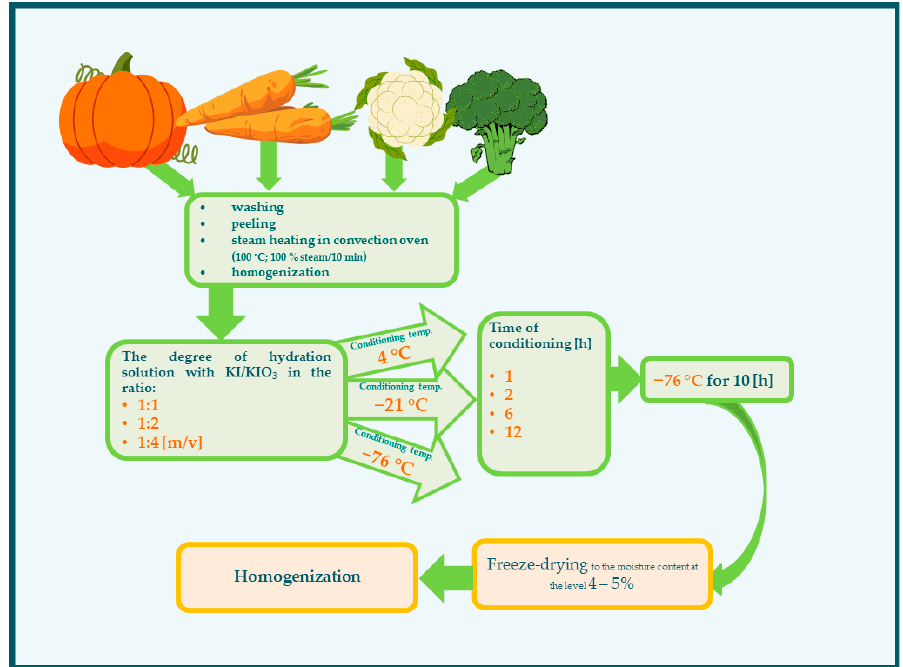
Figure 5. Scheme of the impregnation conditions of vegetables with iodine. Table 3. Parameters of carrier iodination of the iodine carriers.